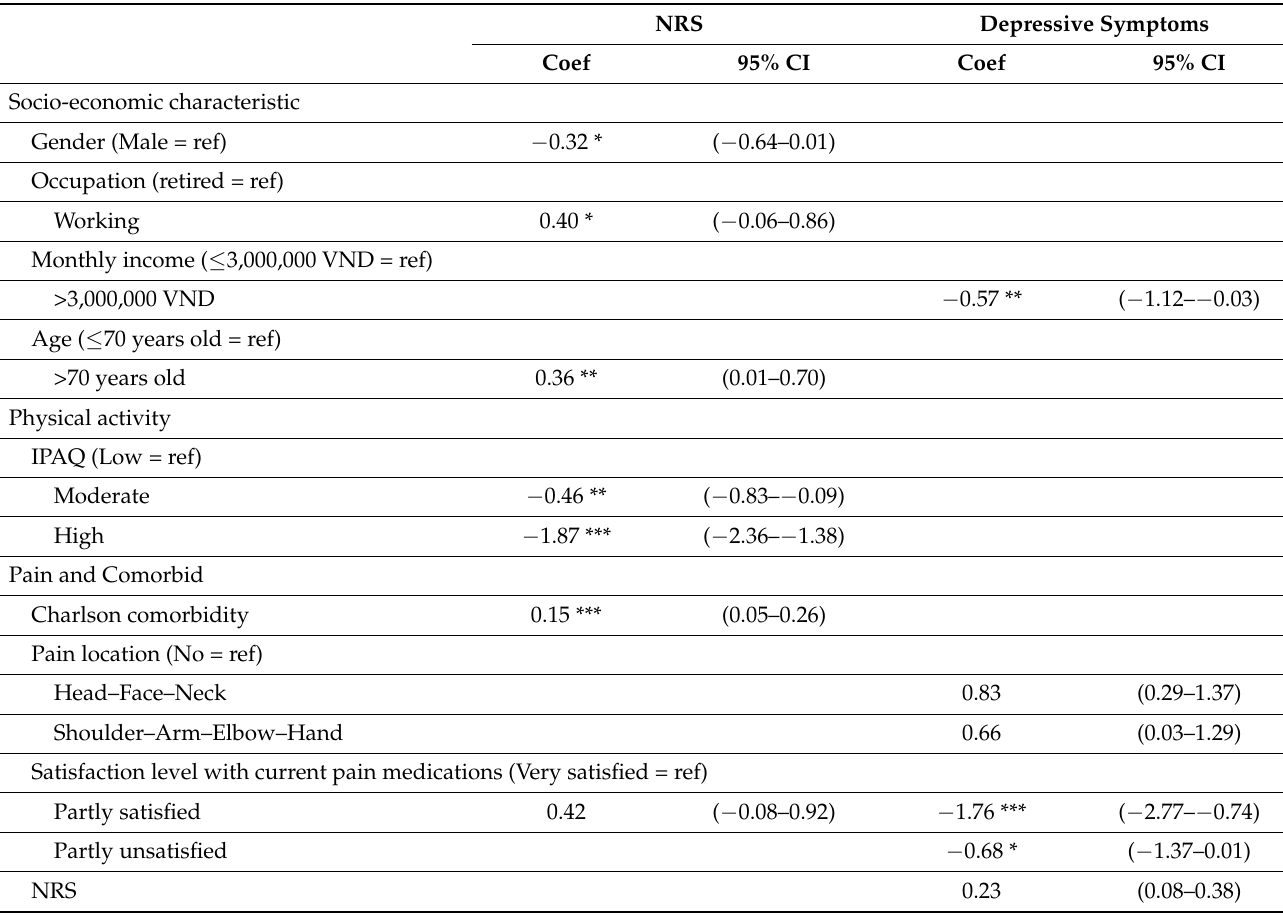
Table 4. Factors associated with depression among the